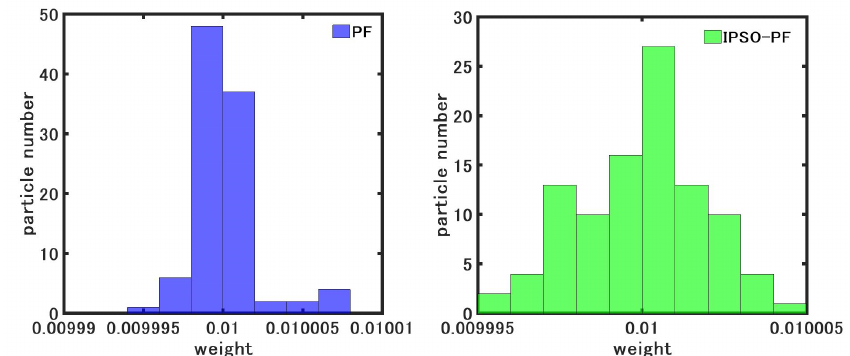
Figure 15. Weight Distribution at SOC = 0.5.